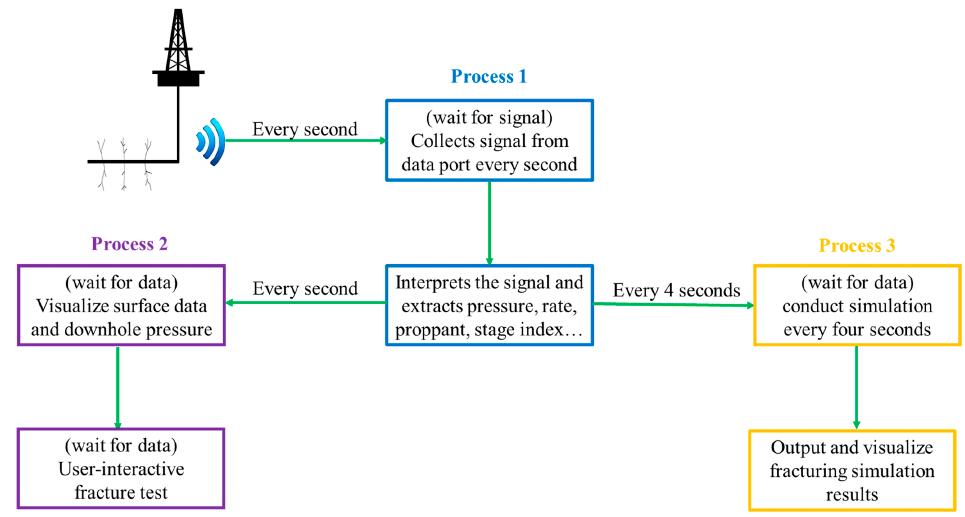
Figure 6. Workflow of the multi-process real-time simulation